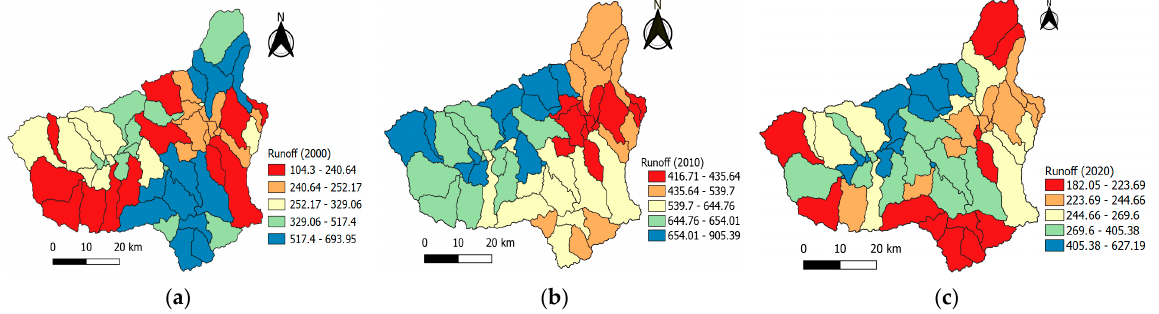
Figure 6. Spatiotemporal patterns of surface runoff during ( a ) 2000, ( b ) 2010, and ( c ) 2020 LULC simulation periods .